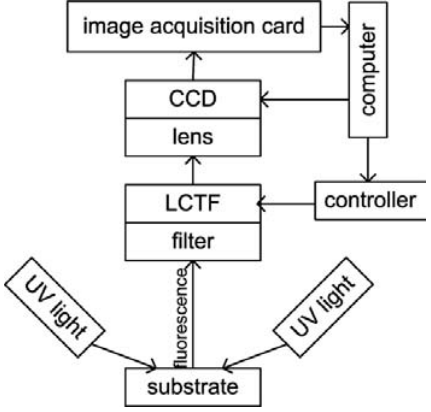
Fig. 1. Spectral imaging system block